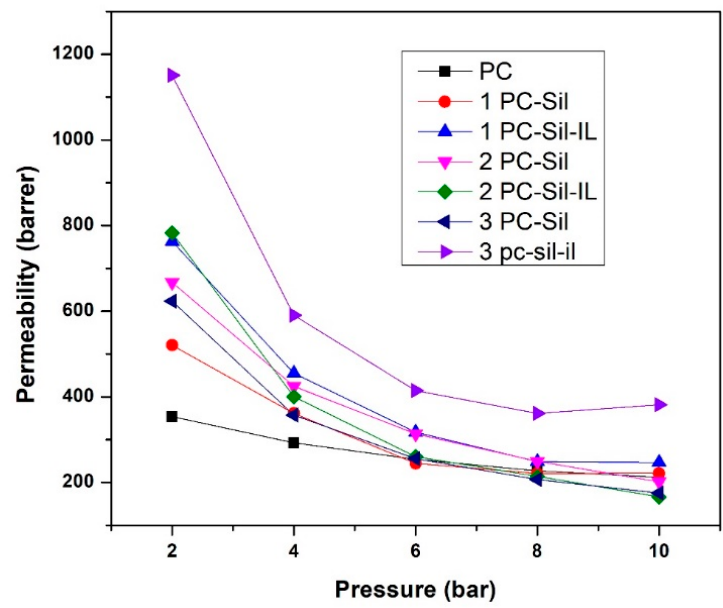
Figure 6. CO 2 permeability of fabricated PC, PC-Sil MMMs, and PC-Sil-IL MMMs at pressure ranging from 2 to 10 bar.